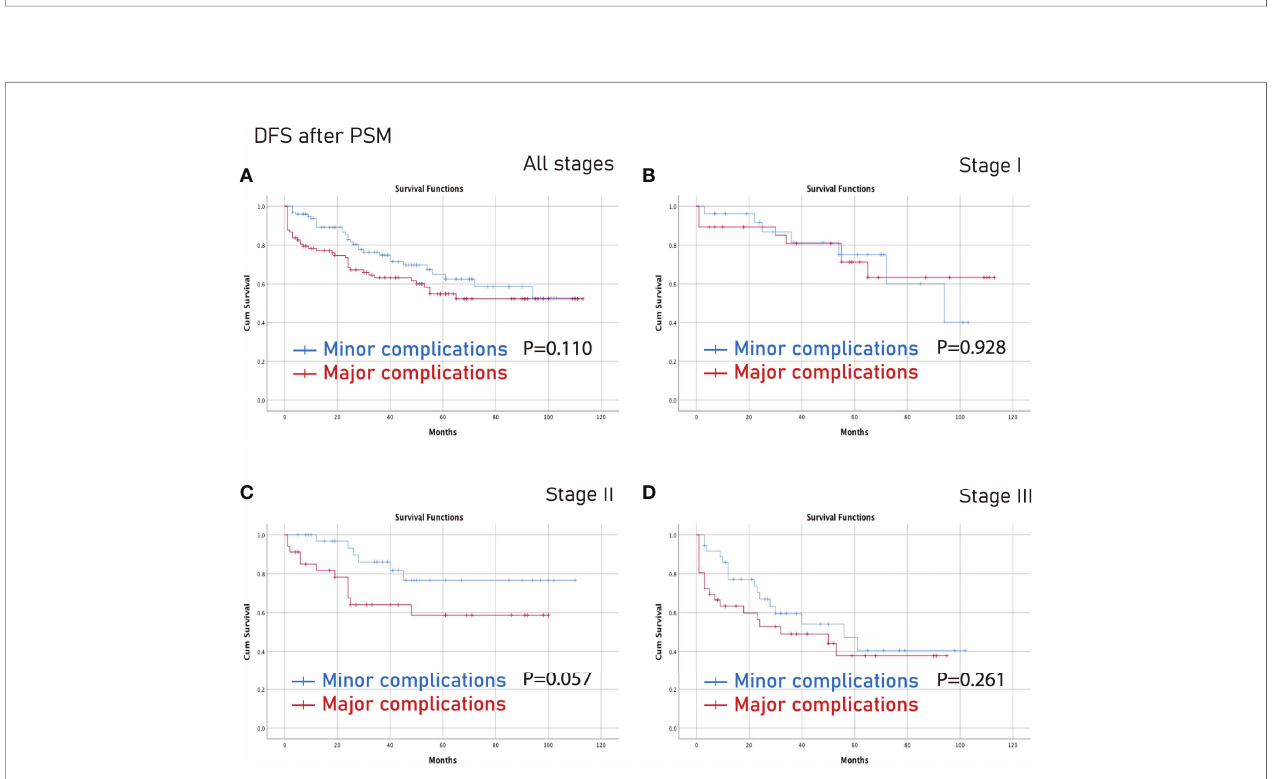
FIGURE 6 | DFS between the major complications group and the minor complications group after PSM. (A) , all stages; (B) , stage I; (C) , stage II; (D) , stage III. DFS, disease-free survival; PSM, propensity score